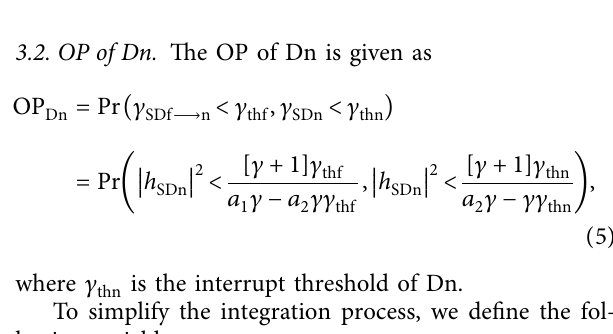
x to Df and Dn. P 2 and a are power allocation coeffi- 1 2 + a � 1, and a 1 2